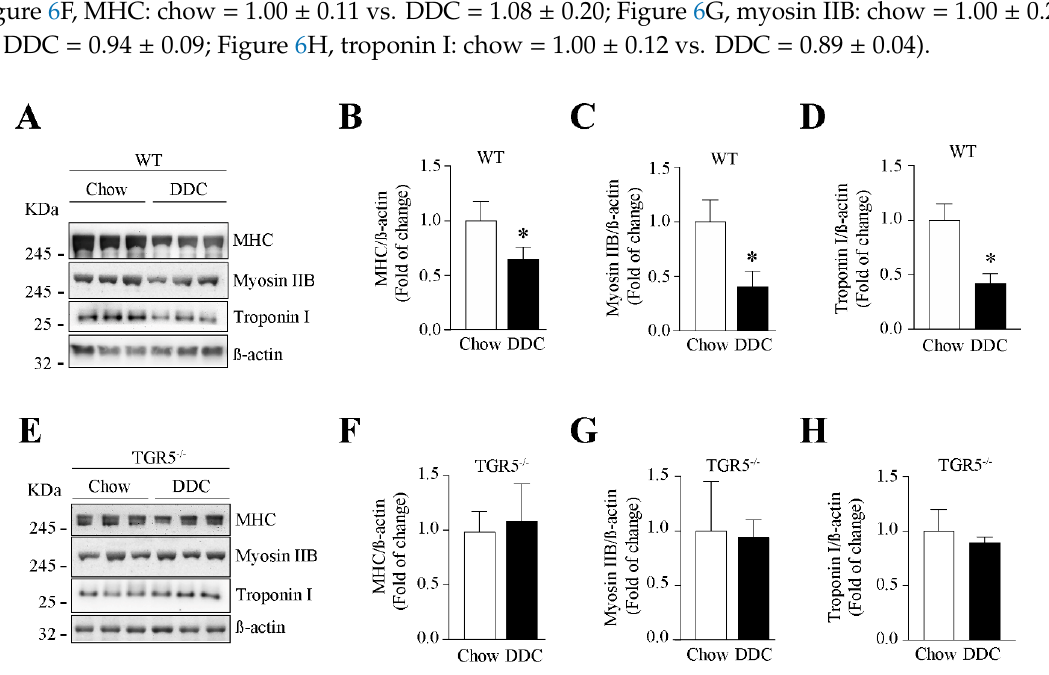
Figure 6. TGR5 participates in reducing the myosin heavy chain (MHC) protein levels in mice with CLD. C57BL/6J male WT and TGR5 -/- mice were fed with a chow or DDC-supplemented diet for 6 weeks. When the experiment was completed, TA muscles were excised and homogenized to